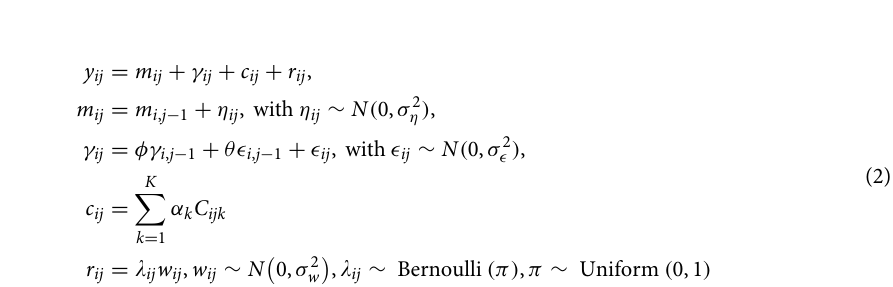
Figure 8. Representation of residuals ( residual ij = y ij − ˆ m ij ) over time considering with probability 1 − π of Y being a standard cycle (non overdispersed) and π being a non-standard cycle (overdispersed), with